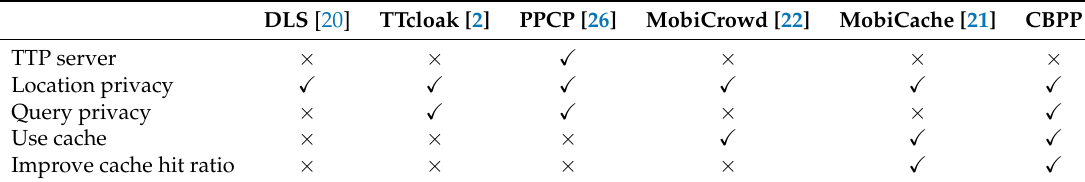
Table 2. Comparison of privacy properties.